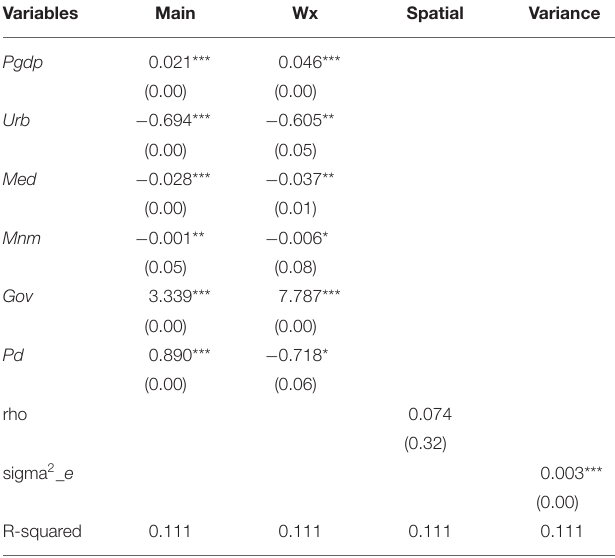
TABLE 7 | LR test and Wald test results. Model